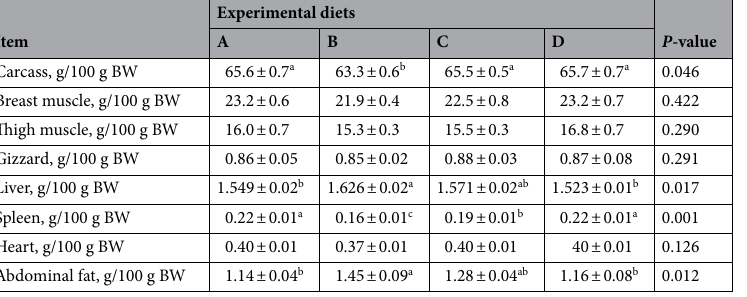
Table 3. Effect of DETOXIZYME supplementation on carcass and internal organs weight under clostridia infection in Cobb 500 broilers. a–c The means values placed at the rows by different superscript letters are significantly different (P < 0.05). Values are expressed as means ± standard error. Abbreviations: (A) control negative (basal diet), (B) control positive (basal diet supplemented with clostridia infection), (C) control positive group diet with 100 g DETOXIZYME/ton of feed, (D) control negative diet group with 100 g DETOXIZYME/ton of feed.